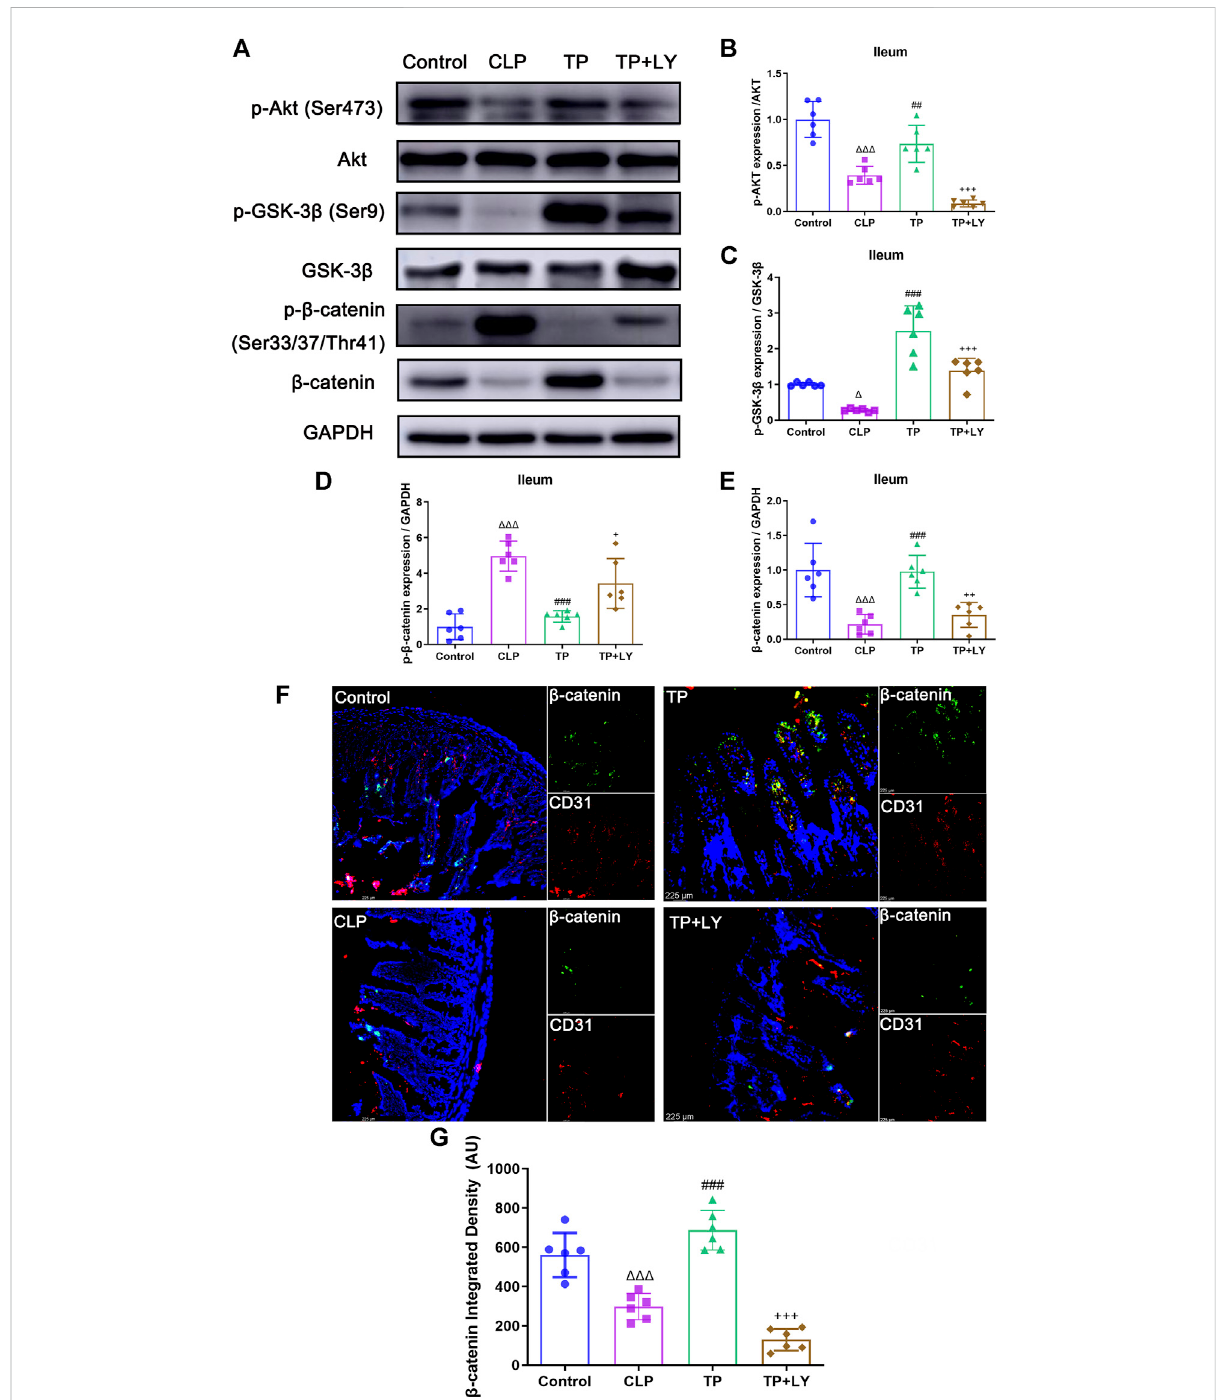
FIGURE 5 Terlipressin protected against CLP challenge through PI3K signaling. (A) Representative bands of p-Akt, Akt, p-GSK-3 β , GSK-3 β , p- β -catenin and β -catenin. (B – E) Quantitative analysis of above-mentioned molecules, n = 6. (F) Dual immuno fl uorescence of CD31 (red) and β -catenin (green) intheileum(×200),andnucleiwerecounterstainedwithDAPI(blue).Scalebars:225 μ m. (G) Quantitativeanalysis:integrated fl uorescencedensityof β -catenin, n = 6.Datawereexpressed by mean± SD. Δ p < 0.05, ΔΔ p < 0.01, ΔΔΔ p < 0.001 vs. Control group. # p < 0.05, ## p < 0.01, ### p < 0.001 vs. CLP group. + p < 0.05, ++ p < 0.01, +++ p < 0.001 vs. TP